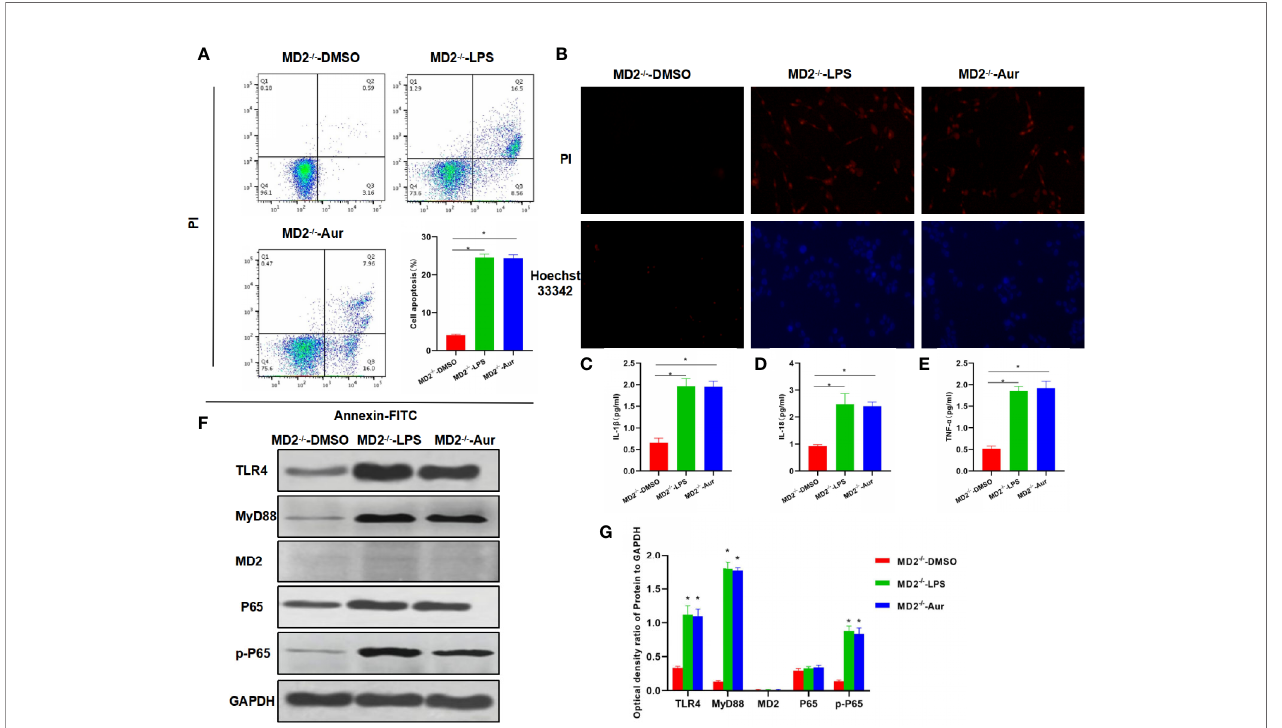
FIGURE 3 | Effects of Aur on KC injury after MD2 knockout. (A) : Detection of apoptotic level (n = 3): There was no signi fi cant apoptosis in the MD2 -/ – DMSO group, while the apoptotic level was signi fi cantly more increased in the MD2 -/ – LPS and MD2 -/ – Aur groups than the MD2 -/ – DMSO group, however, without signi fi cant difference between groups. Comparison between groups, *P <0.05. (B) : PI staining and Hoechst 33342 staining (n = 3): There were no positive cells in the MD2 -/ – DMSO group, without signi fi cant apoptosis. The number of positive cells was not signi fi cantly different between the MD2 -/ – LPS and MD2 -/ – Aur groups. (C – E) : Expression of in fl ammatory factors (n = 3): The expression level of in fl ammatory factors was not signi fi cantly different between the MD2 -/ – LPS and MD2 -/ – Aur groups, which was signi fi cantly more increased than the MD2 -/ – DMSO group. Comparison between groups, *P <0.05. (F, G) : Detection of the protein expression level (n = 3): The expression level of TLR4, MyD88, MD2, and p-P65 was relatively low in the MD2 -/ – DMSO group, which was signi fi cantly upregulated in the MD2 -/ – LPS and MD2 -/ – Aur groups, however, without statistical signi fi cance between groups. Comparison between groups, *P